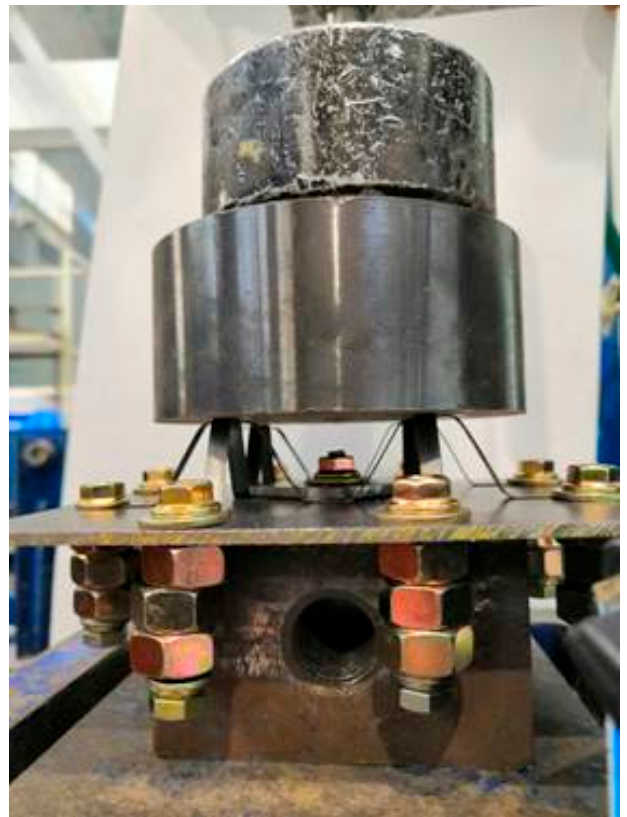
Figure 5. Device diagram of experiment.